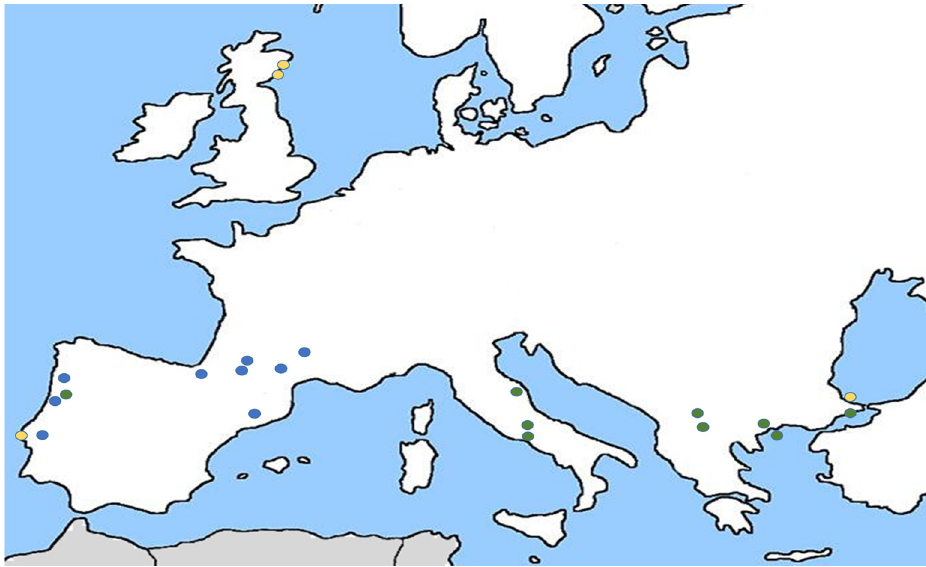
Figure 1. Geographical distribution of the case studies analysed in this study. Green circles: slope; blue circles: fluvial; yellow circles: coastal case studies.